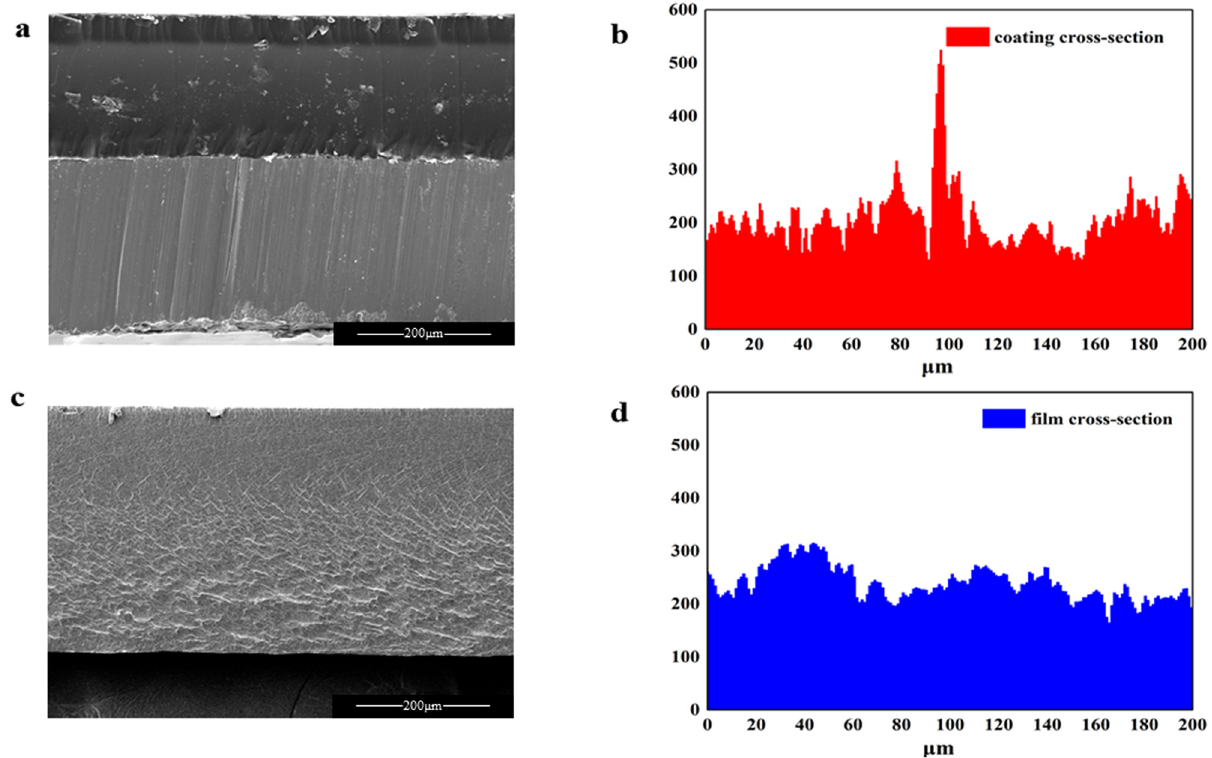
Figure 13: ( a ) Coating cross - section, ( b ) EDS of coating cross - section, ( c ) cross - section of PTFE fi lm formation, ( d ) EDS of fi lm cross - section, ( a and c ) magni fi cation level of 200 × .